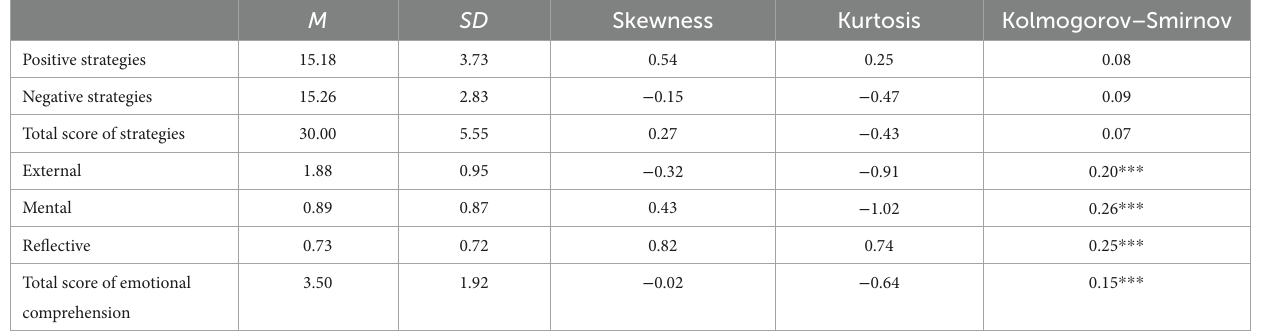
TABLE 1 Scores of peer conflict resolution strategies and emotional comprehension in children.